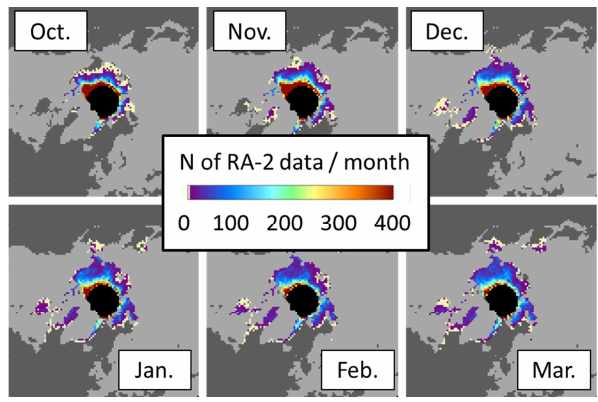
Figure 2. Average number N of Envisat RA-2 data per 100km grid cell per month for the period 2002/03 to